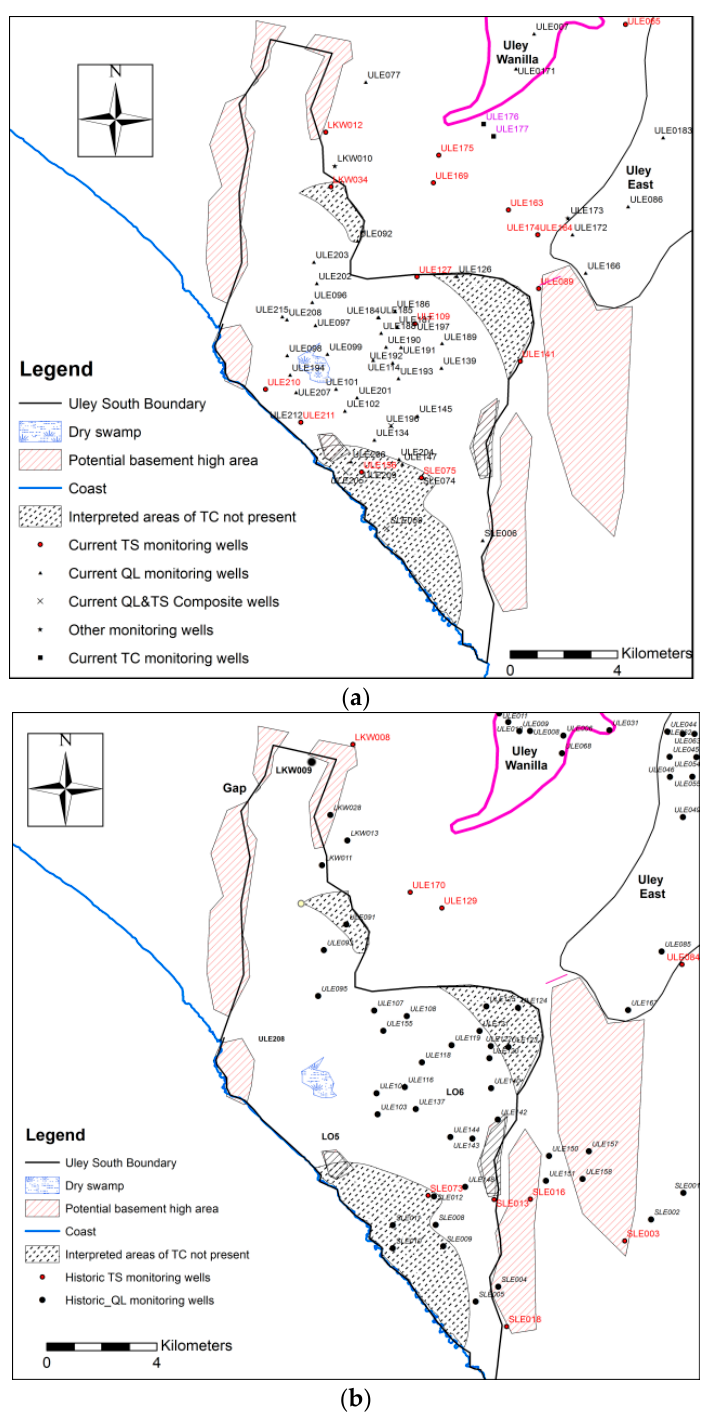
Figure 4. Monitoring wells; ( a ) Current; ( b ) Historic.